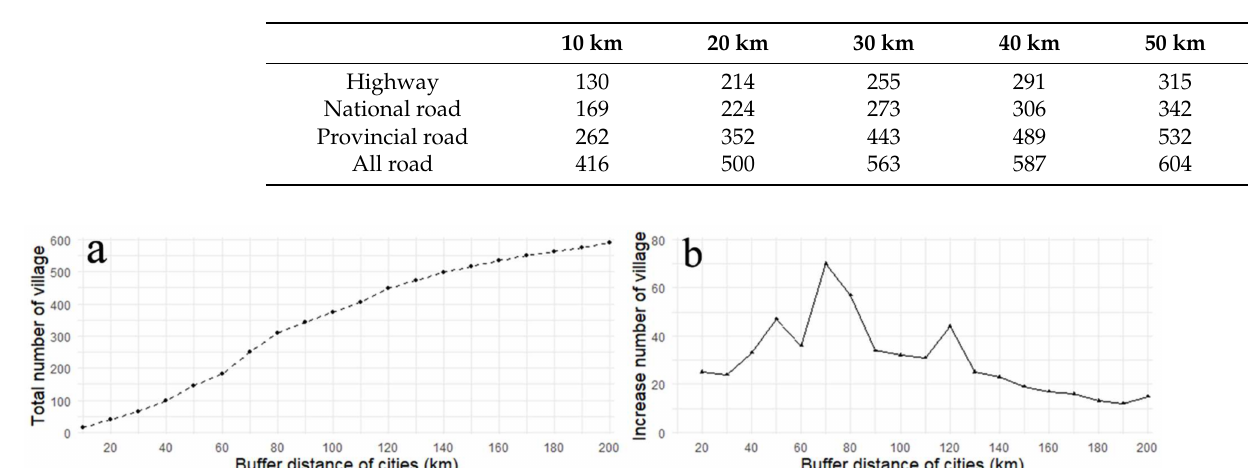
Table 2. The relationship between the number of RT villages and buffer range of different types of roads.